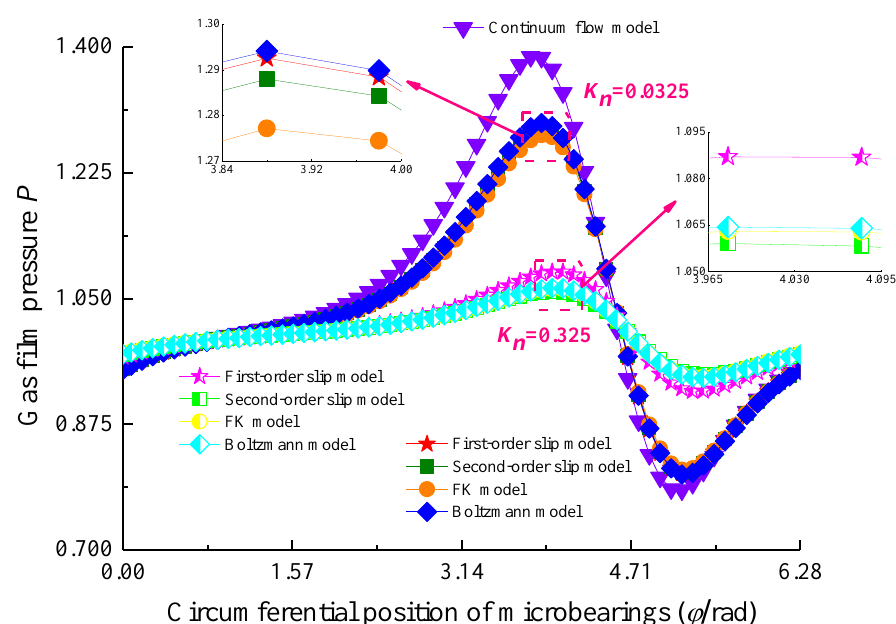
Figure 3. The circumferential fluid film pressure distributions at the mid-plane of microbearings for different Knudsen numbers ( ε = 0.6, Λ = 4, B / D = 0.3).